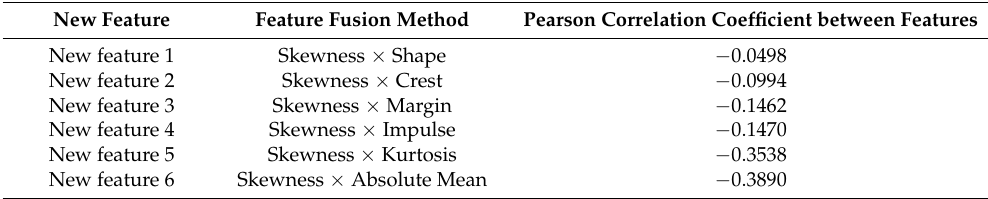
Table 11. New features based on skewness factor fusion.